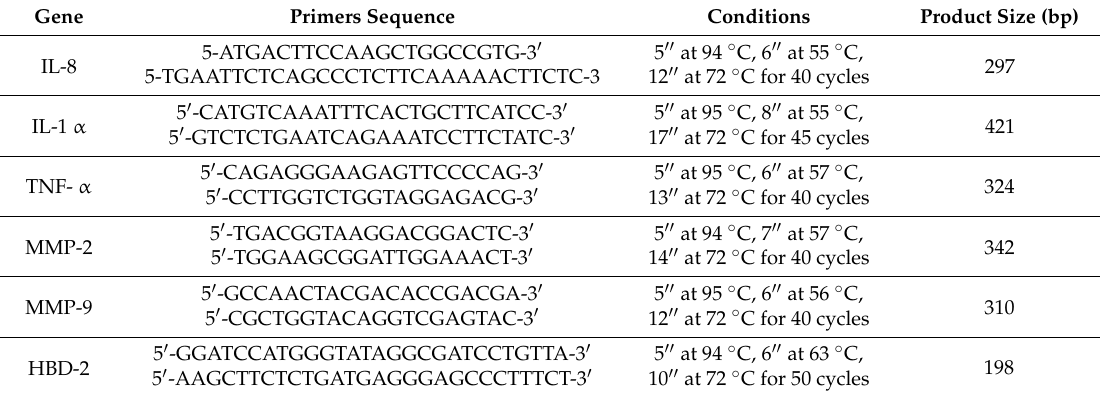
Table 3. Primer sequences and amplification